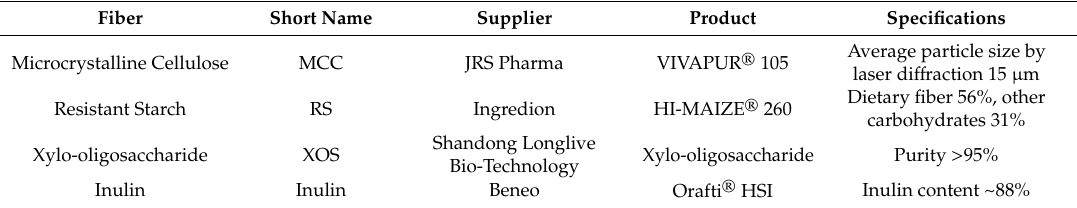
Table 2. Commercial / Isolated fiber samples (data from the